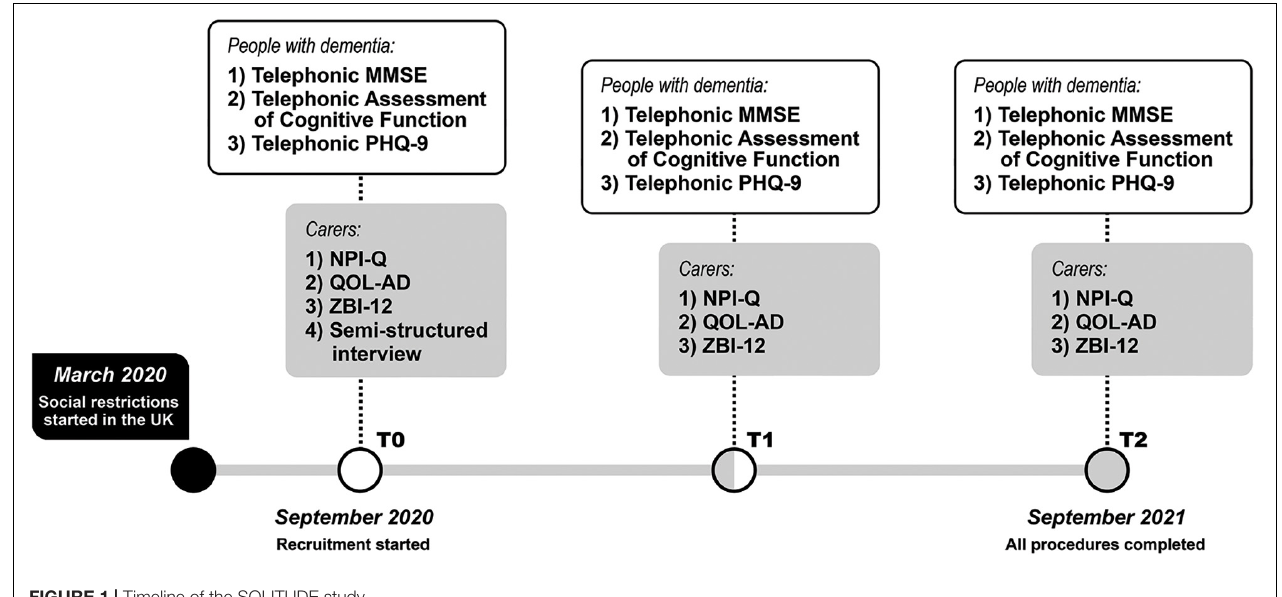
FIGURE 1 | Timeline of the SOLITUDE study.